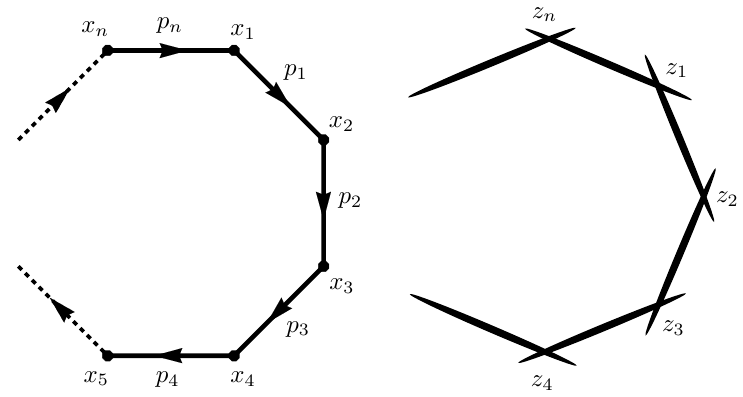
Figure 1 . The transformation between dual-momentum space and momentum-twistor